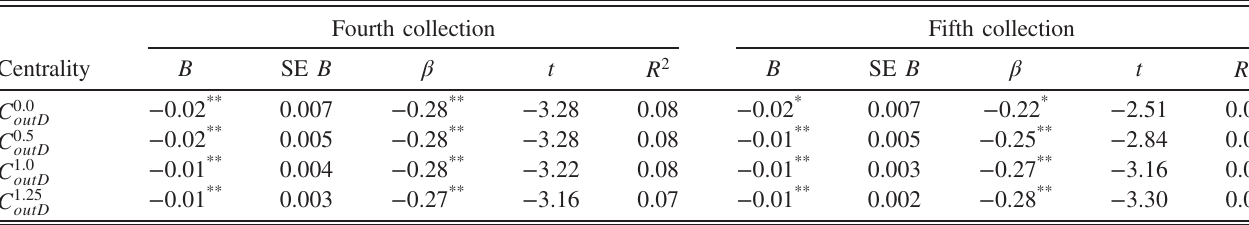
TABLE III. Summary of the linear regression for anxiety shift as predicted by weighed outdegree from fourth and fifth collection, with α ∈ f 0 . 0 ; 0 . 5 ; 1 . 0 ; 1 . 25 g : the unstandardized estimate ( B ), the standard error for the unstandardized estimate (SE B ), standardized estimate ( β ), t -test statistic ( t ), and R -squared ( R 2 ). We consider networks without instructional staff. Significant p values are marked with an